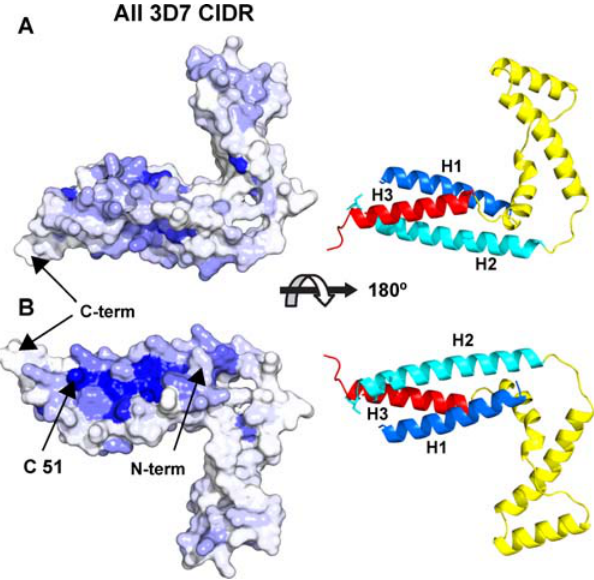
Figure 3. Sequence conservation of all CIDR domains of the 3D7 genome mapped on to the MC179 structure. High to low conservation is mapped as a color gradient (dark blue to white) on the molecular surface of MC179. A highly conserved surface patch (dark blue) means that a high percentage of the residues at that position in the alignment of all 3D7 CIDR domains (Figure S2) are identical to the surface-exposed MC179 residue. (A) View of one side of MC179 reveals little conservation. (B) View after a rotation of 180 u shows a highly conserved region on the molecule. Cys 51 is conserved in all CIDR domains. Other highly conserved residues that contribute to the conserved surface between Cys 51 and the N-terminus are Trp 14, Asp 21, Trp 55, Lys 59, Glu 62, and Ile 66 (not shown). Little conservation is seen on the surfaces of the connecting helices. The cartoons to the right are reference diagrams in the same orientations as the surfaces. A few highly conserved residues are not visible at the surface because they are completely buried. Sequence alignments (Figures S1, S2 and S3) were used as input to the Protskin server [38] to produce this figure and Figure